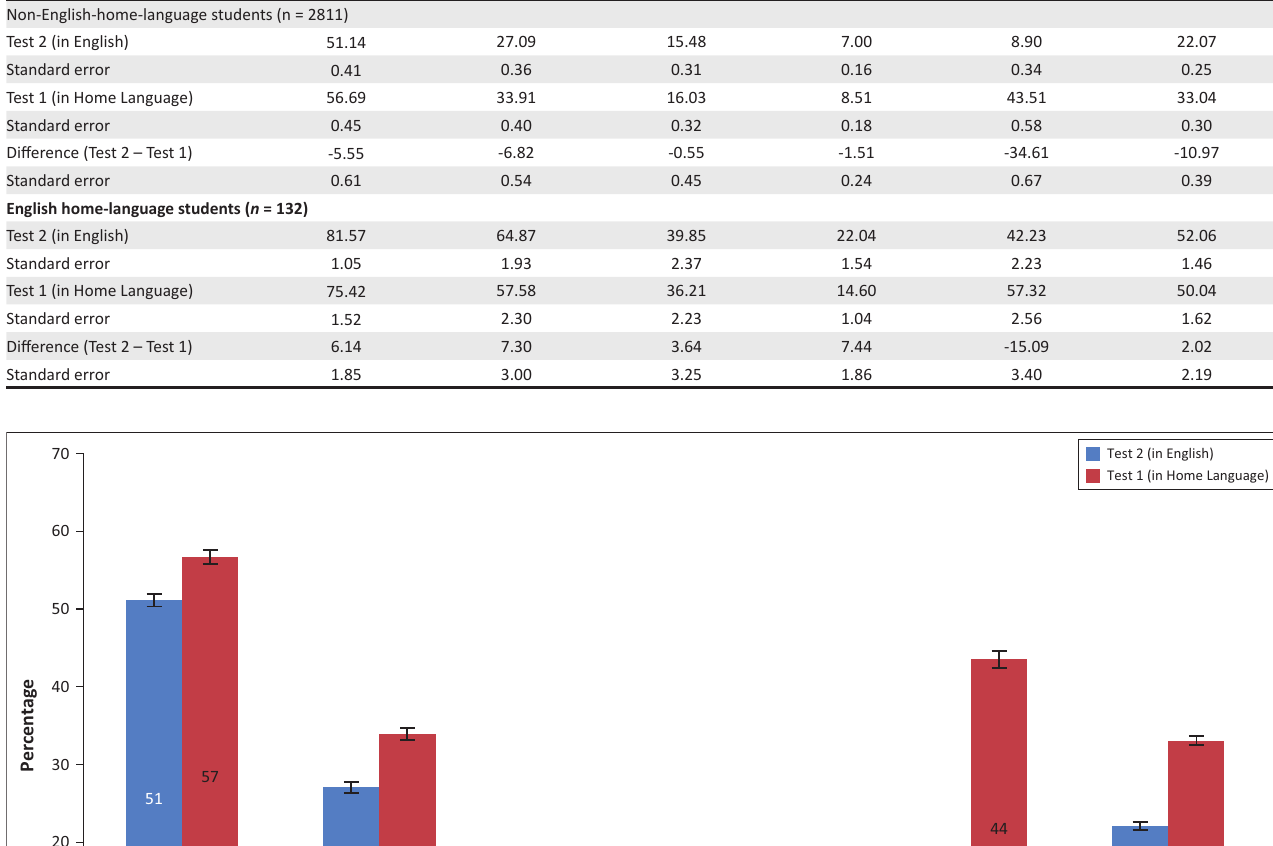
TABLE 8: Average performance ( % ) by literacy process in Test 1 (Systemic Evaluation) and Test 2 (National School Effectiveness Study) for students whose home language is and is not English (standard errors clustered at the individual level). Variable Cloze/matching-word- to-picture (9 items)